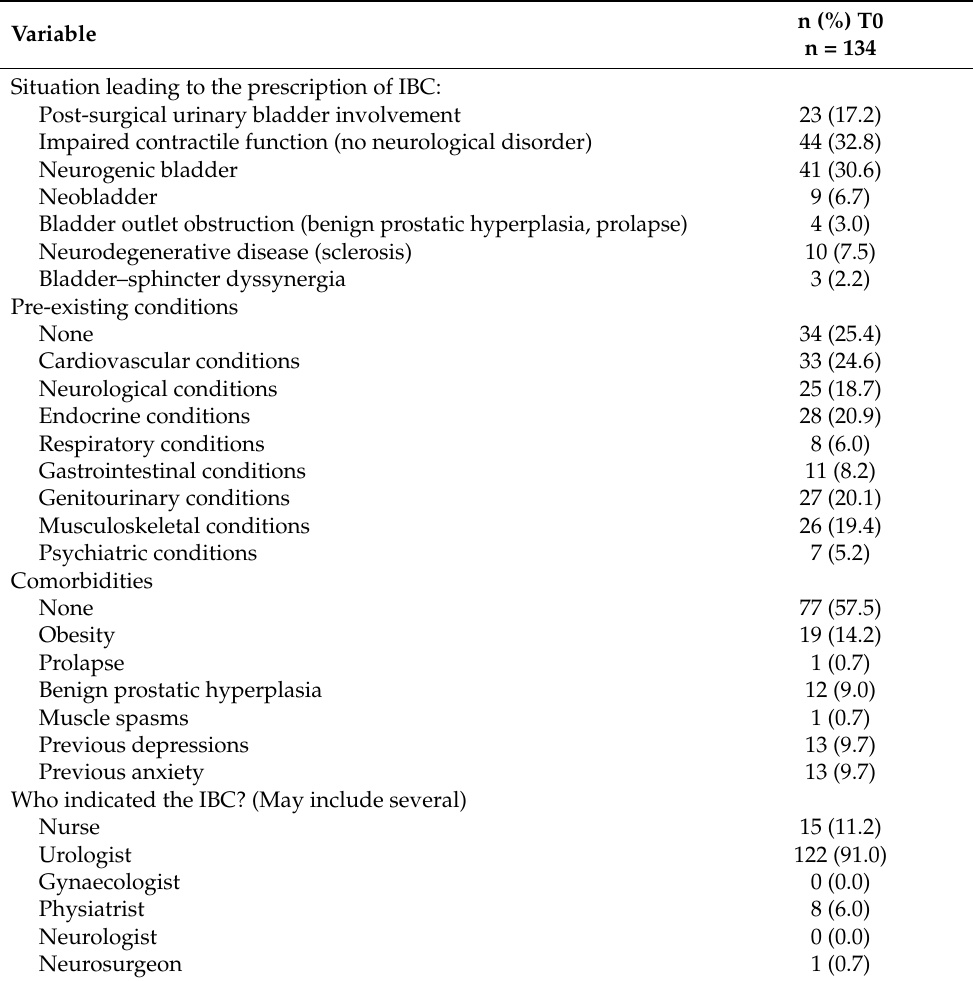
Table 2. Clinical characteristics of the study